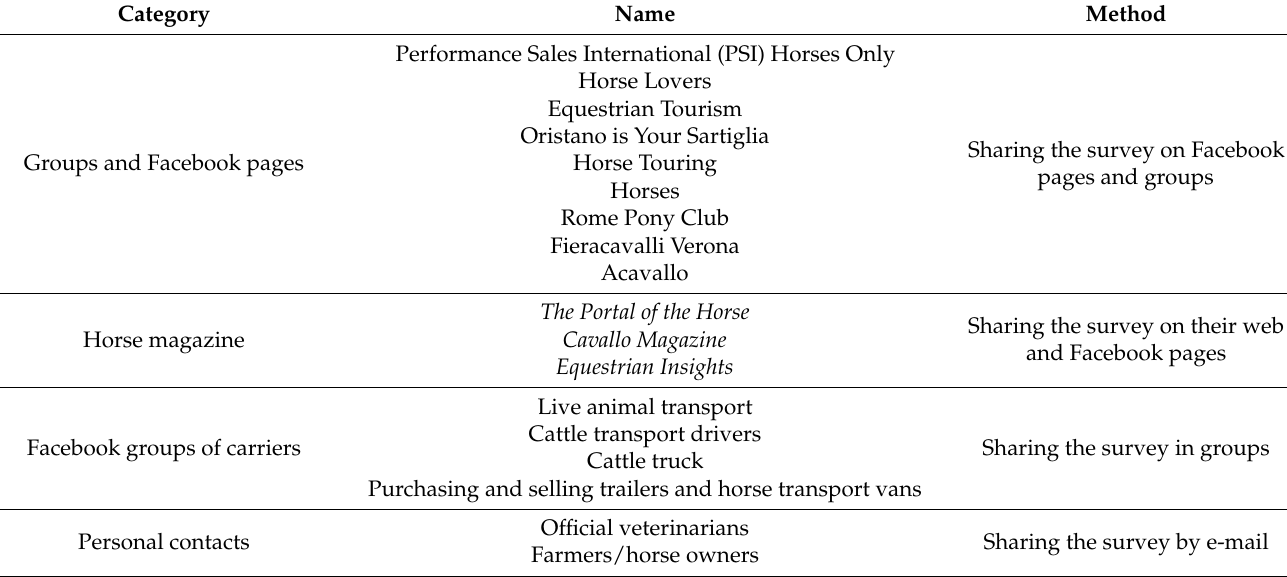
Table 1. Distribution pathways for the survey on horse road transport practices, transport-related problem behaviors, horse injuries, and horse handler injuries in